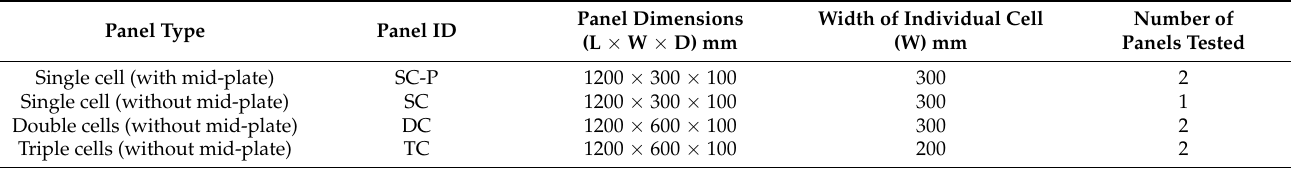
Table 1. Details of Test